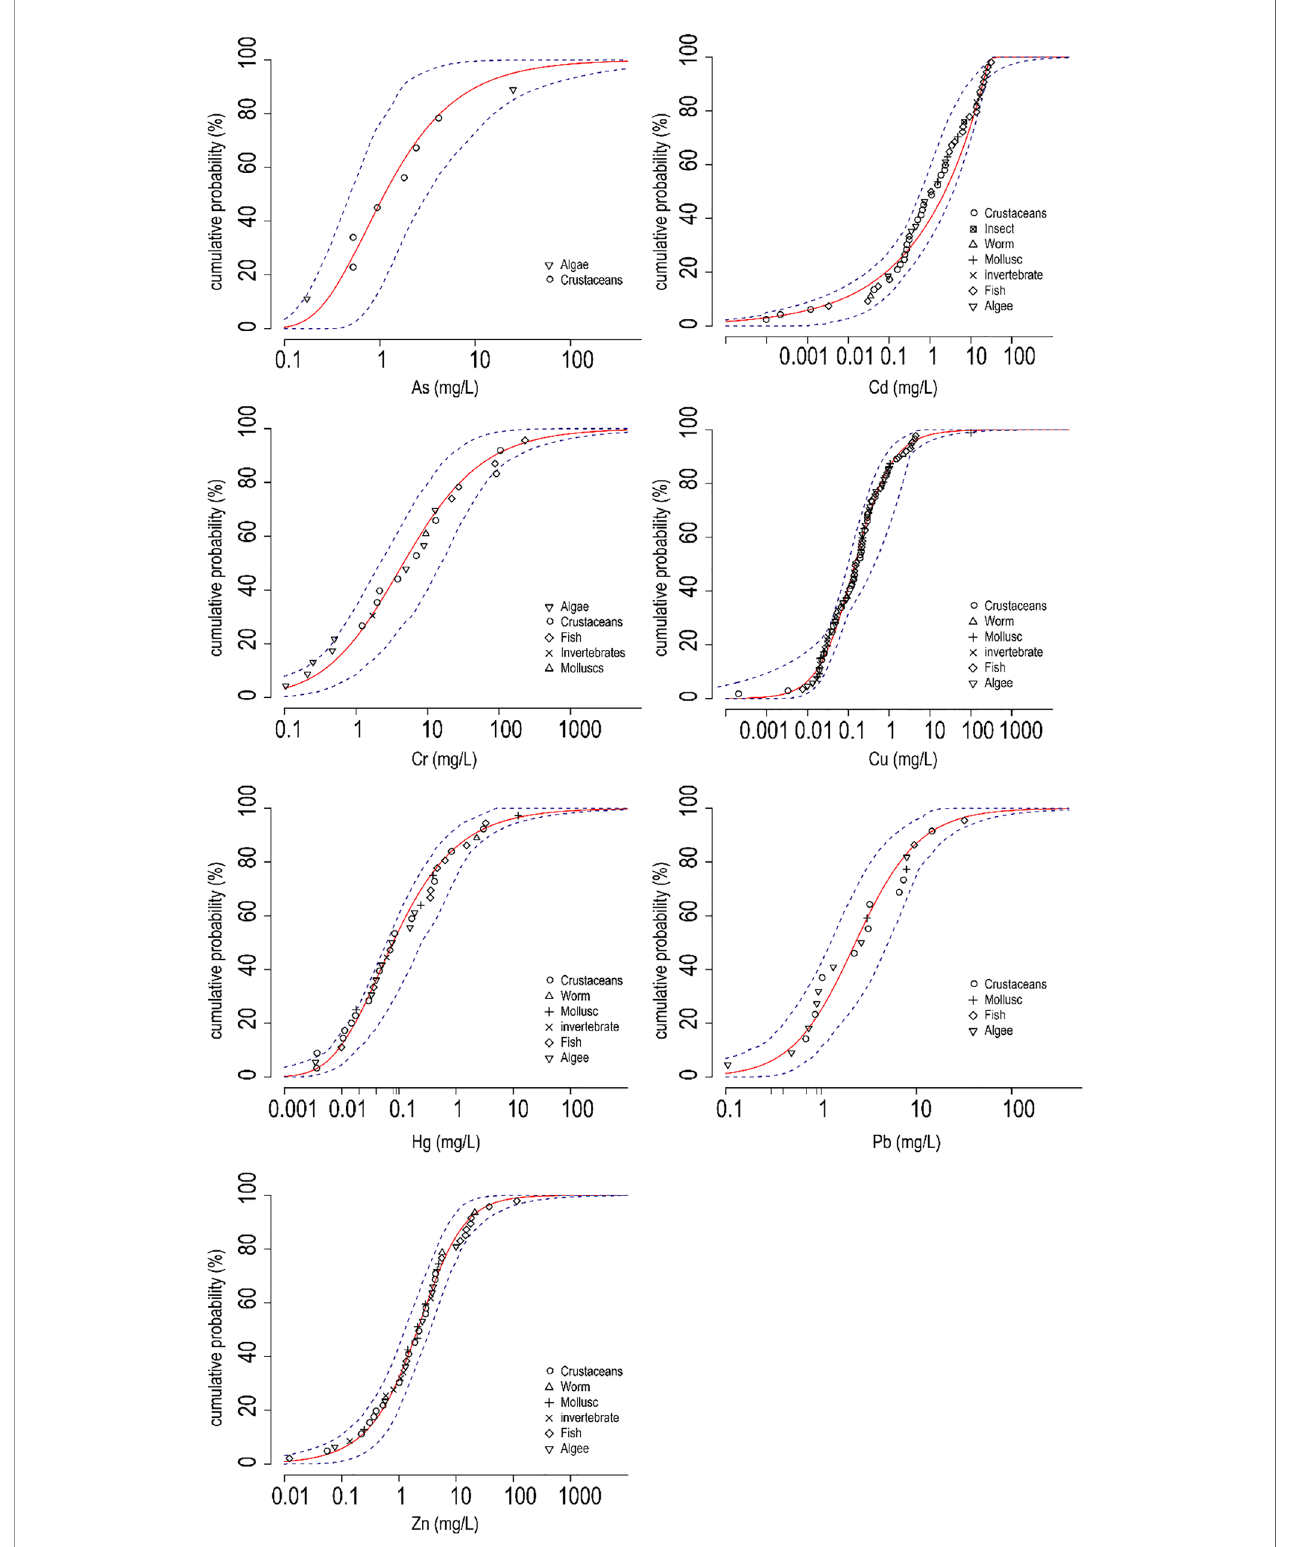
FIGURE 8 | The correlation analysis of heavy metals in the seawater of coastal Zhuhai in 2017 and 2018,